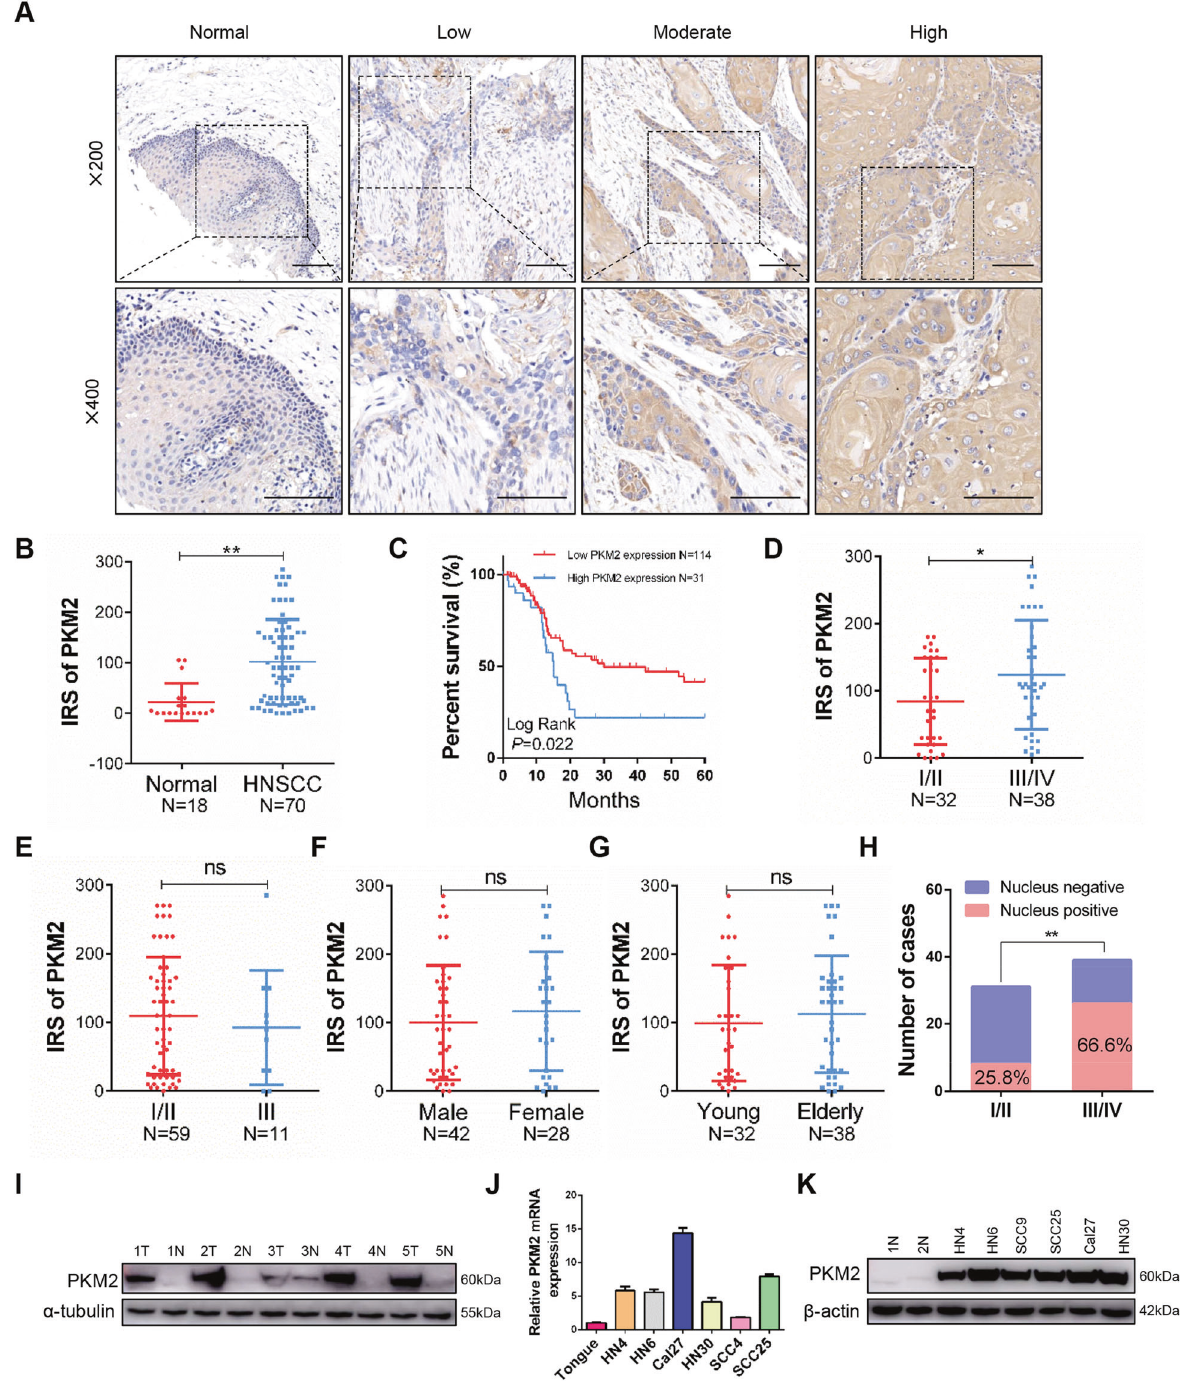
Fig. 1 Overexpression of PKM2 correlates with poor prognosis. A Representative images of high, moderate, and low expression of PKM2 in HNSCC were shown. Bar: 50 μ m. B IHC score of PKM2 in HNSCC patients ( n = 70) and normal controls ( n = 18) was analyzed. c Overall survival analysis was performed based on PKM2 expression in 144 HNSCC patients. D – G The correlation between PKM2 expression and TNM stage, pathological grade, gender, and age was analyzed in HNSCC patients. H The correlation between nuclear PKM2 expression and TNM stage was analyzed in HNSCC. I PKM2 protein levels were determined in 5 paired HNSCC samples using western blotting (N adjacent normal tissue, T tumor tissue). J PKM2 mRNA expression in HNSCC cell lines and primary normal oral keratinocytes was detected using qRT-PCR. K The relative expression of PKM2 in HNSCC cell lines and normal oral epithelial cells as determined by western blotting. * P < 0.05, ** P <